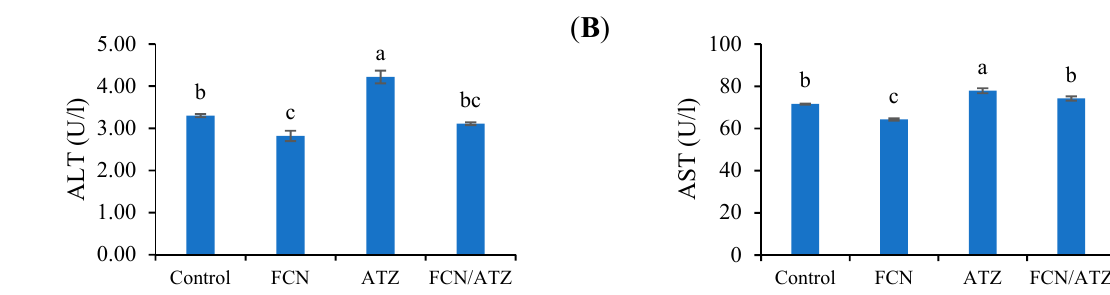
Figure 3. The liver-related enzymes of Nile tilapia fed fucoidan and exposed to atrazine. Bars present means ± S.E. with different letters; differ significantly ( p < 0.05). The groups are the control, fish fed dietary fucoidan (FCN), fish fed basal diet and exposed to atrazine (ATZ), and fish fed FCN and exposed to ATZ (FCN/ATZ). Serum alanine aminotransferase (ALT) ( A ) and aspartate aminotransferase (AST) ( B ).